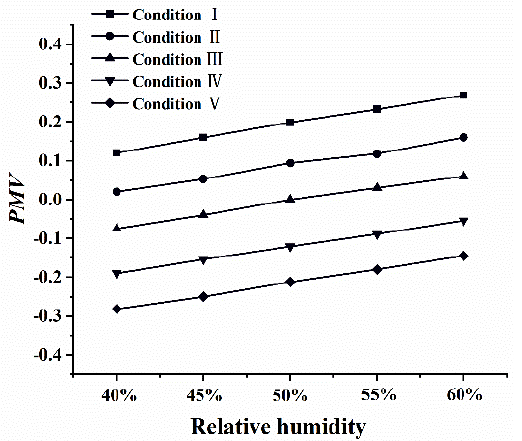
Figure 7. Influence of relative humidity changes on PMV under conditions I~V.